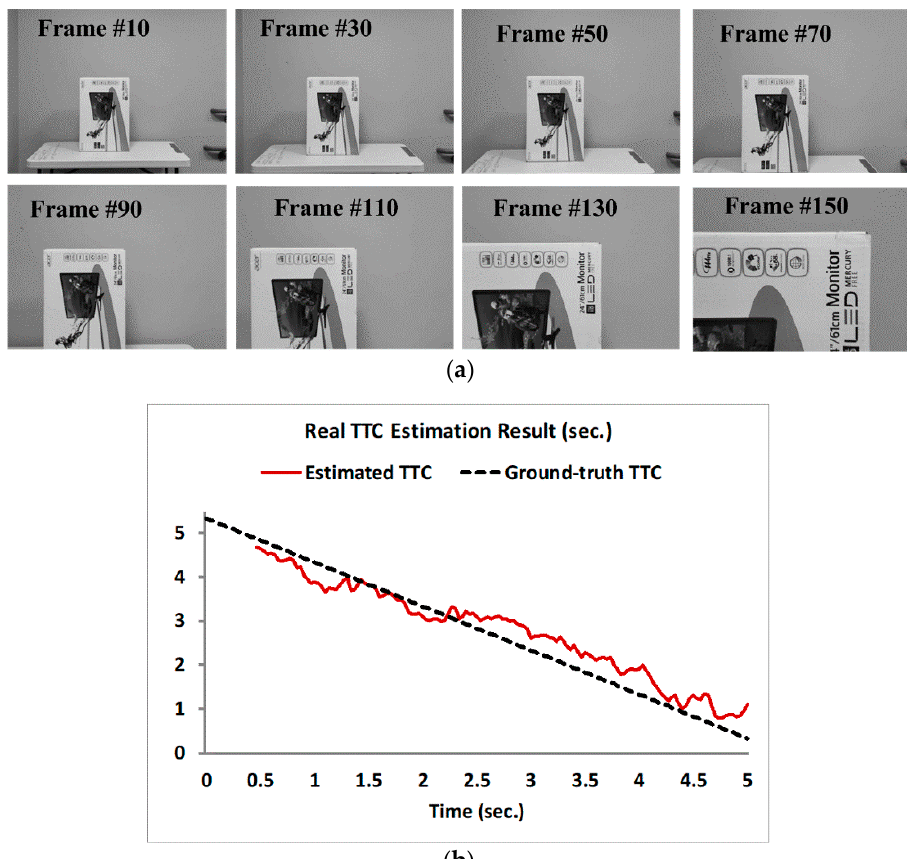
Figure 5. TTC estimation results for a real-world looming sequence. ( a ) Image sequence captured from a moving camera approaching a stationary object. ( b ) Global average of estimated TTC for the obstacle in the sequence.